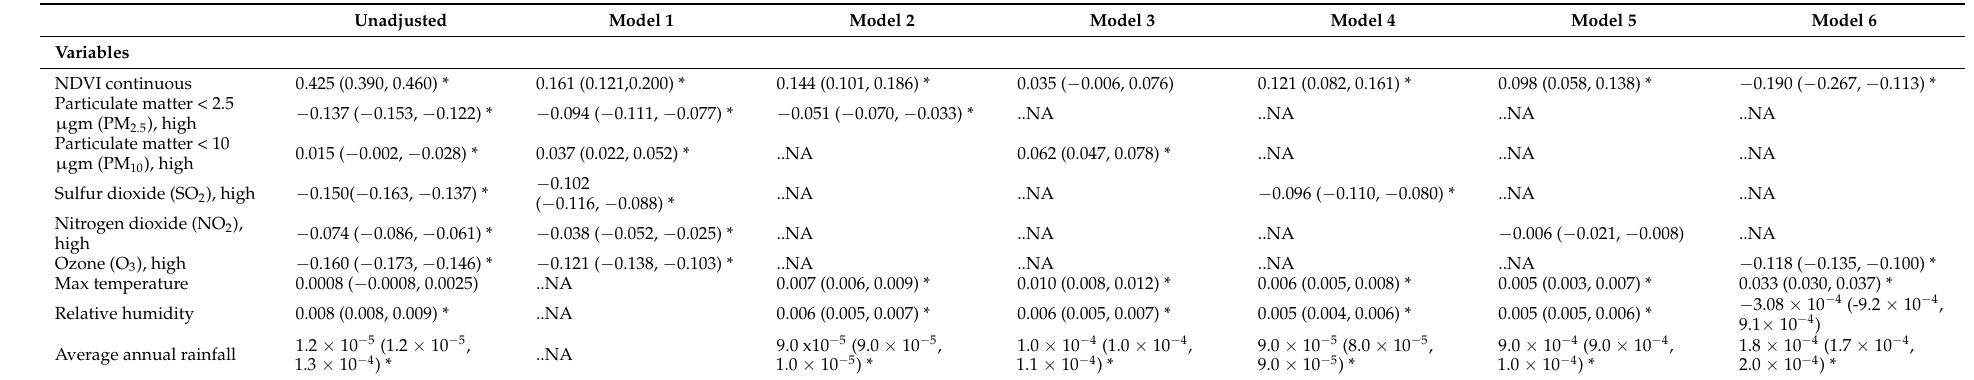
Table 2. Generalized estimation equation (GEE) result coefficients ( β ) (95% CI, lower, upper) of NDVI for association of asthma prevalence and air pollutants at high